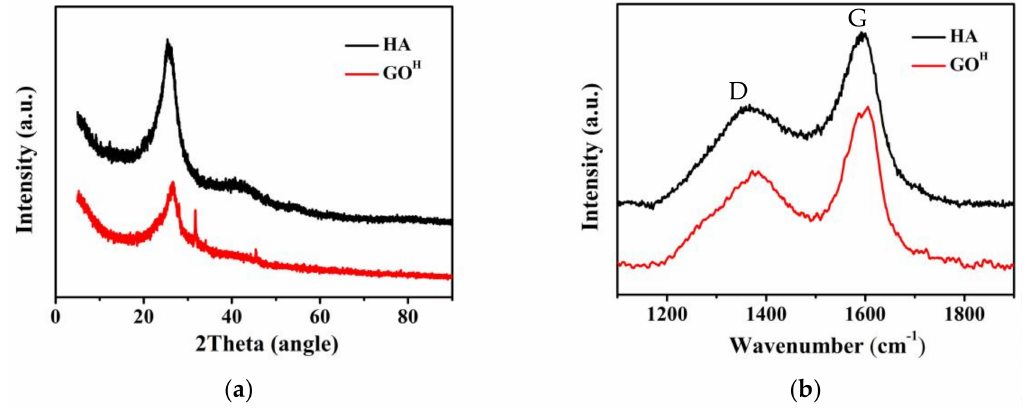
Figure 2. ( a ) X-Ray Diffraction (XRD) patterns; ( b ) Raman spectra of HA and GO H . The XPS survey spectra shows C1s peaks at ca. 285.7 eV along with O1s peaks at ca. 532.6 eV (Figure 3a), indicating that GO H has a lower C/O atomic ratio (2.76) than HA (3.53). The deconvoluted C1s peak of GO H discloses the presence of 32.0 atom % of sp 2 C=C (284.3 eV), 28.7 atom % of sp 3 C − H/C − C (284.9 eV), 13.8 atom % of C − OH (285.3 eV), 7.8 atom % of C − O − C (285.8eV), 4.4 atom % of C=O (286.7 eV) and13.4 atom % of C(O) − O (288.8 eV) groups (Figure 3b) [27]. It is worth noting that, compared to GO H , the HA possesses lower content of C=C (29.9%), C − OH (7.5%) and C(O) − O